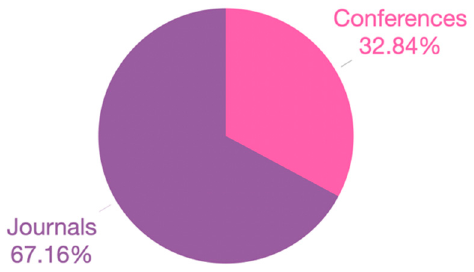
Figure 4. Type of selected articles.